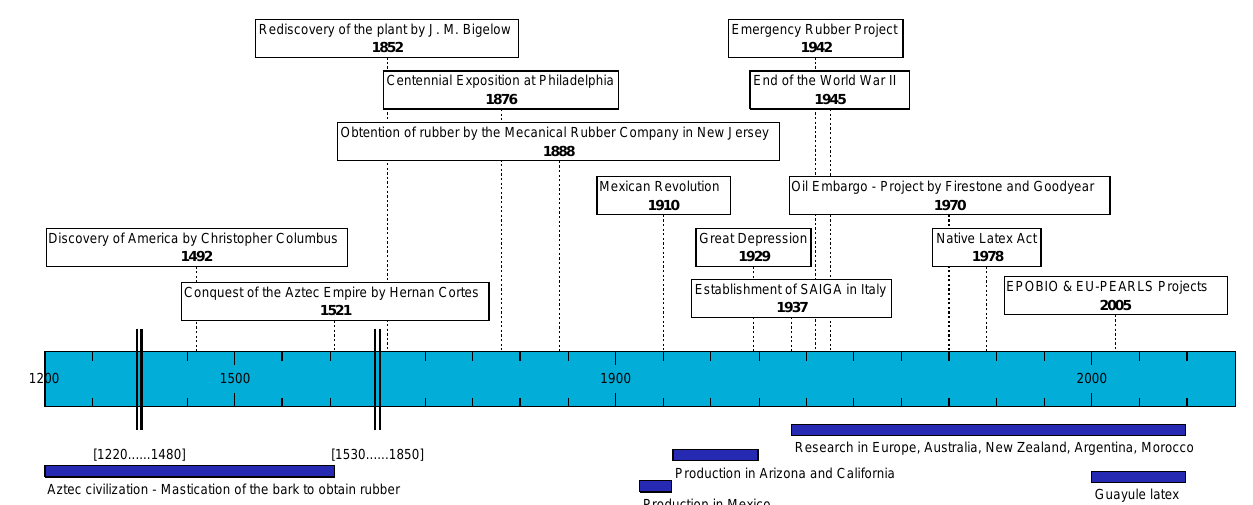
Figure 2. Guayule history